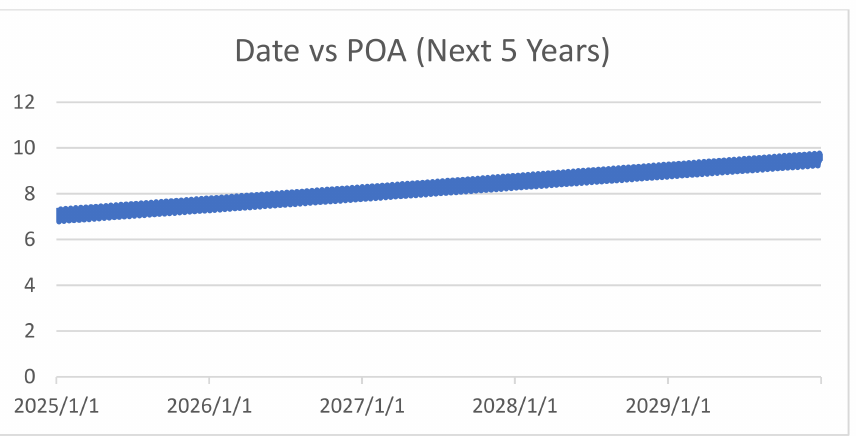
Figure 12. Second 5 years’ prediction results of the plane of array (POA) from 1 January 2025 to 1 January 2029.